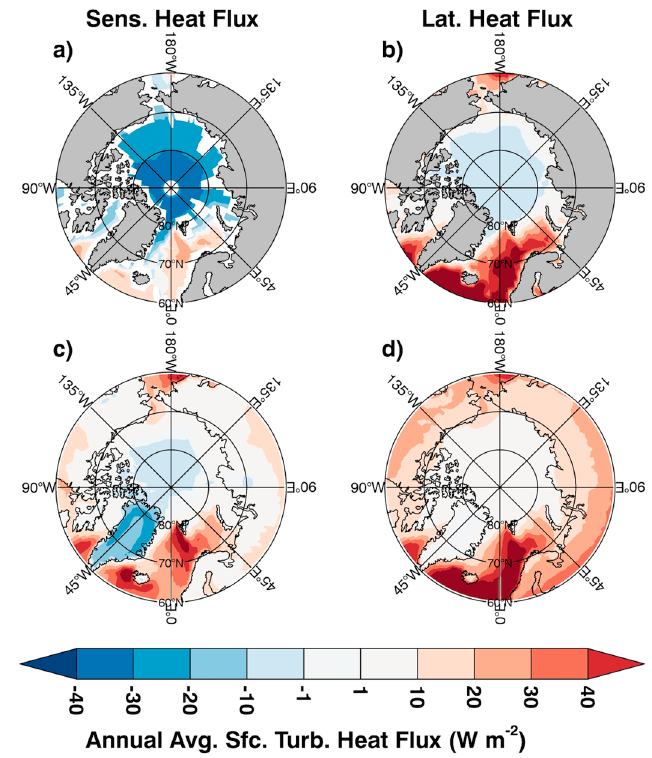
Figure 7. Top panels show the satellite-retrieved annually-averaged SH ( a ) and LH ( b ) between 2003 and 2015 for the Arctic Ocean. Bottom panels show the present-day annually-averaged SH ( c ) and LH ( d ) fluxes poleward of 60° N from a 16-member CMIP5 climate model ensemble using the RCP8.5 forcing. Present-day is defined as the first 20 years of the simulation (2006–2026).